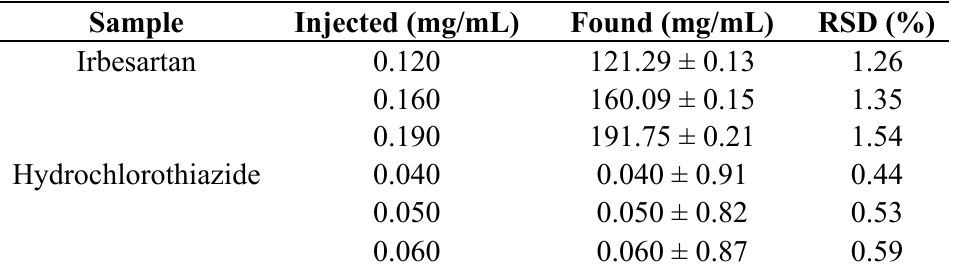
Table 9. Precision of the RP-HPLC